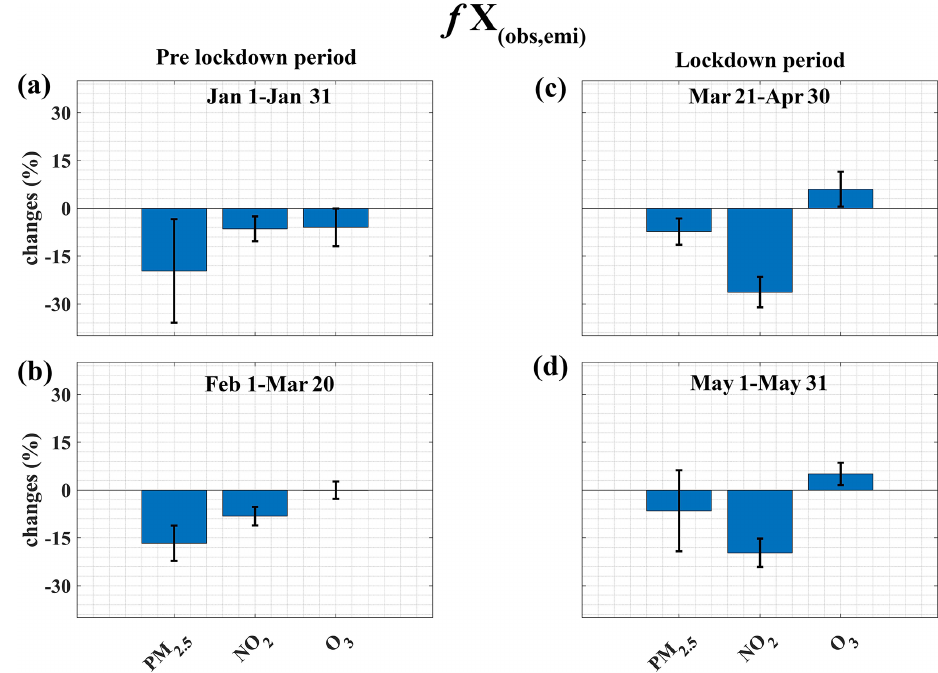
Figure 2. Mean in situ PM 2 . 5 , NO 2 , and O 3 concentration changes with meteorology accounted for between 2020 and 2019. Results of computations according to our first case ( f X (obs , emi) ) in Sect. 3. Error bars represent the 1 σ of the mean of 10 metropolitan